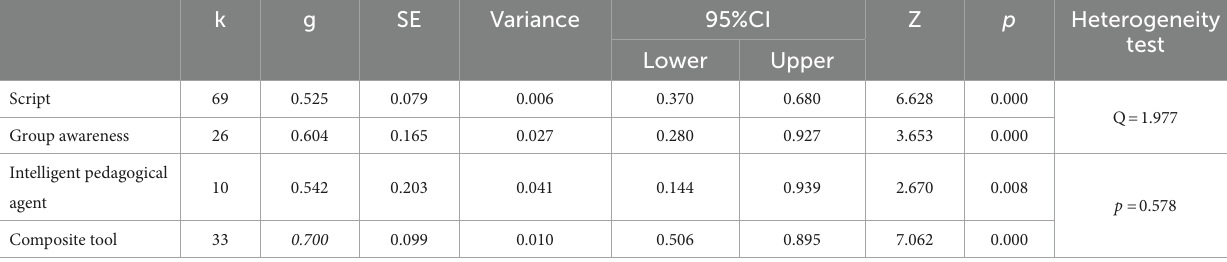
TABLE 5 Overall effectiveness of various regulated learning